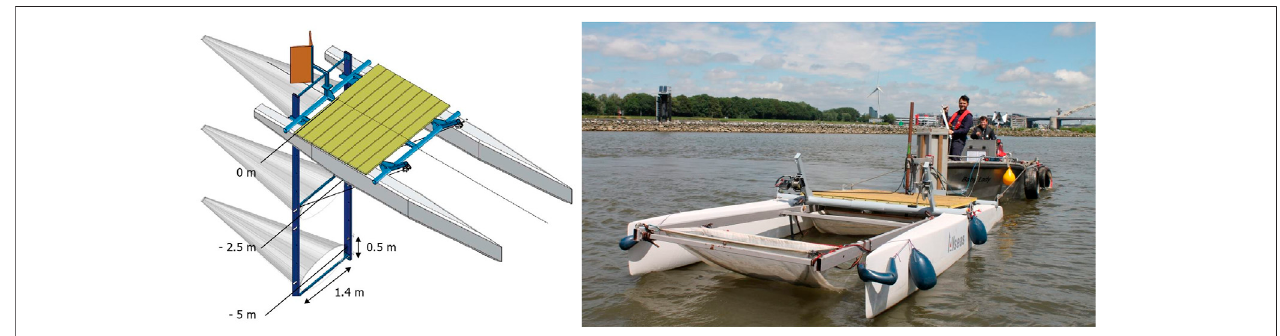
FIGURE 3 | [left] schematic of the sampler when sampling and [right] photo of the sampler navigated by the baby lady on the Nieuwe Maas